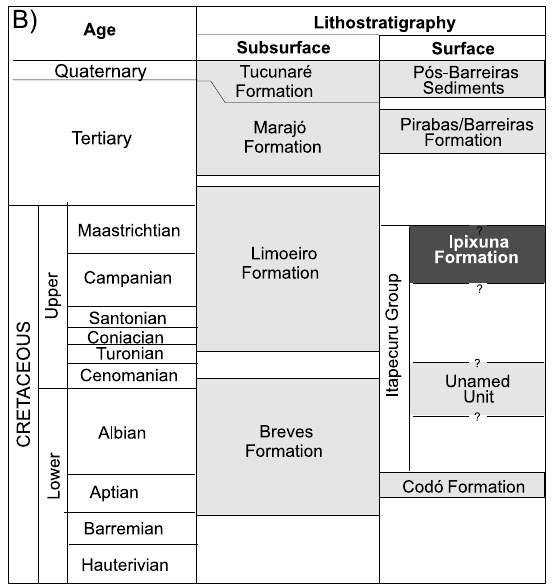
Fig. 2 – Lithostratigraphy of the Cametá Sub-basin, where studied kaolin deposits, represented by the Ipixuna Formation, are